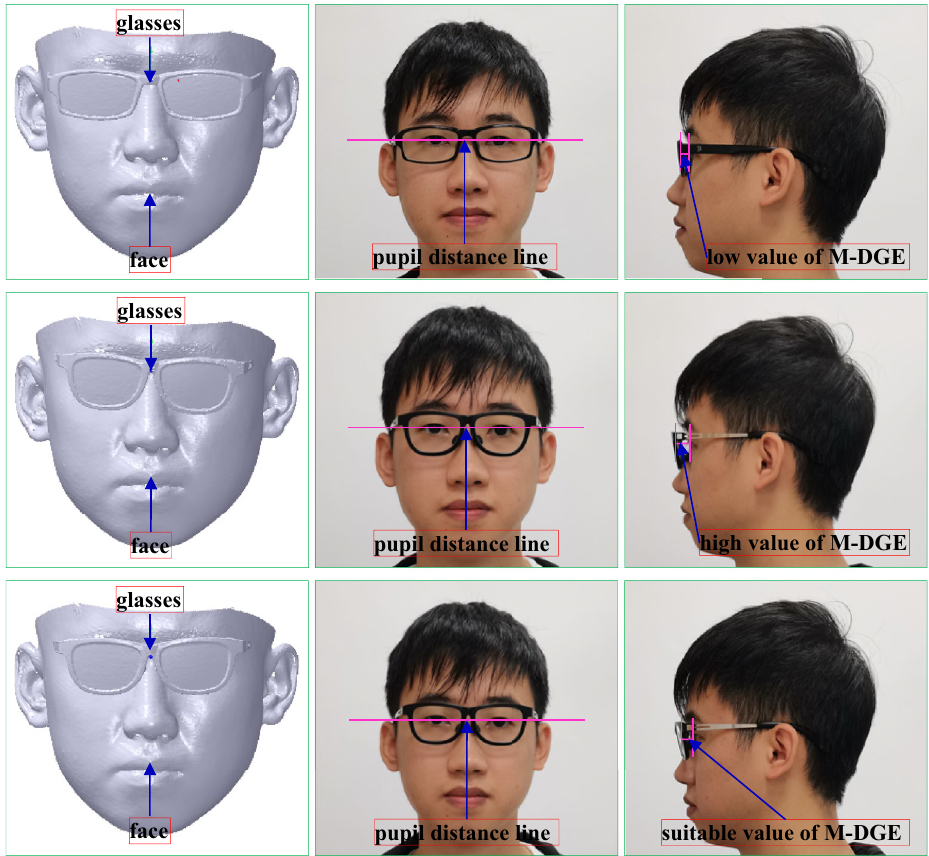
Figure 30. The try-on results of the myopic glasses of example 2. From left to right: the scanned face with glasses, the front view, the left view. From top to bottom: commercial glasses, the method of Liu 10 , our